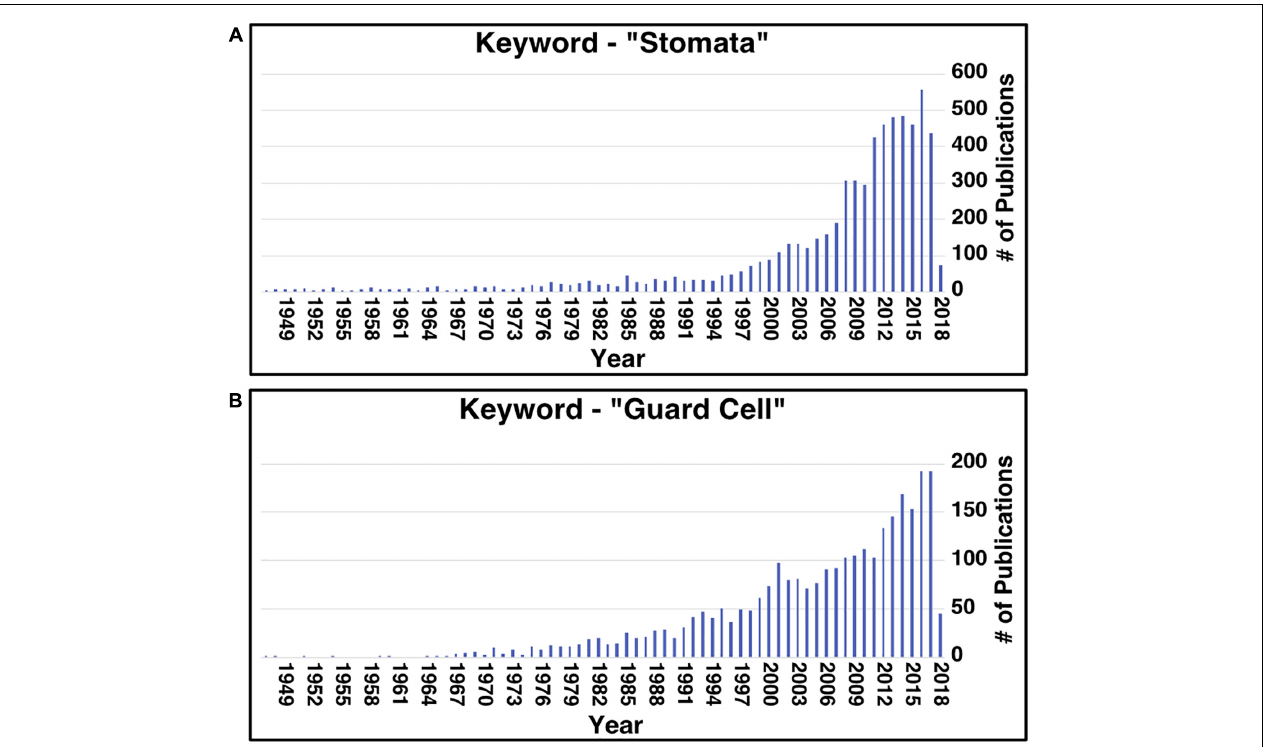
FIGURE 1 | Number of publications per year related to stomata and guard cell research since 1949. Results of searching the PubMed database using the key words “stomata” (A) and “guard cell” (B)